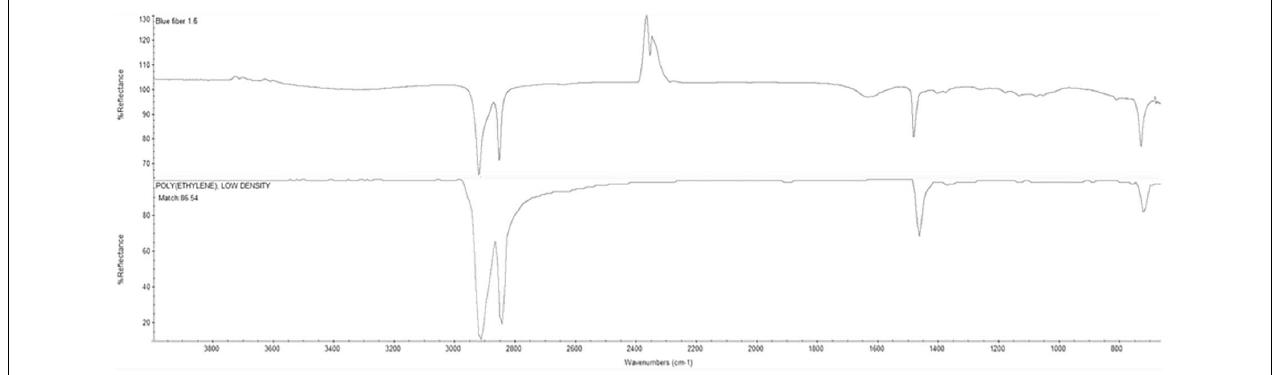
FIGURE 1 | Fourier Transform Infrared - Attenuated Total Reflectance (FTIR-ATR) results (upper spectrum) for blue PE multifilament yarn from Lumat (United States) revealed an 86% match to standard polyethylene low density signal from the XYZ database (lower spectrum)